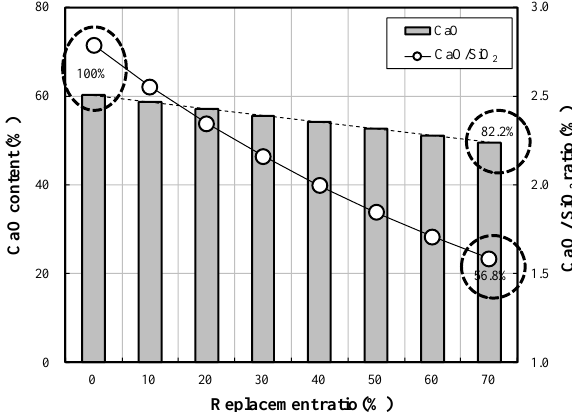
/ iO 2 ratio with respect to replacement